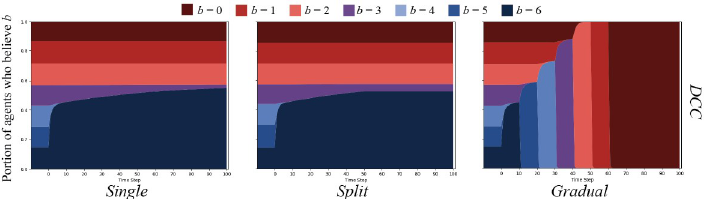
Fig 7. DCC results on ER random networks. DCC on ER random networks with N = 500, and connection chance ρ = 0.05. Graphs show the percent of agents who believe B with strength b over time.